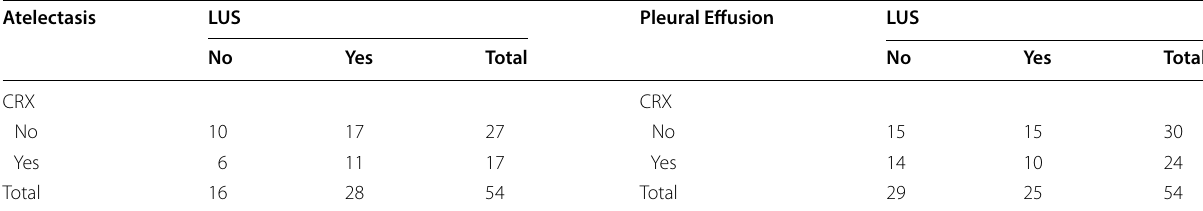
Table 4 Discordant pairs of newly detected atelectasis and pleural effusion for lung ultrasound and chest X-ray when concomitantly performed ( n 54) between days 0 and 4 in 98 patients after abdominal surgery =